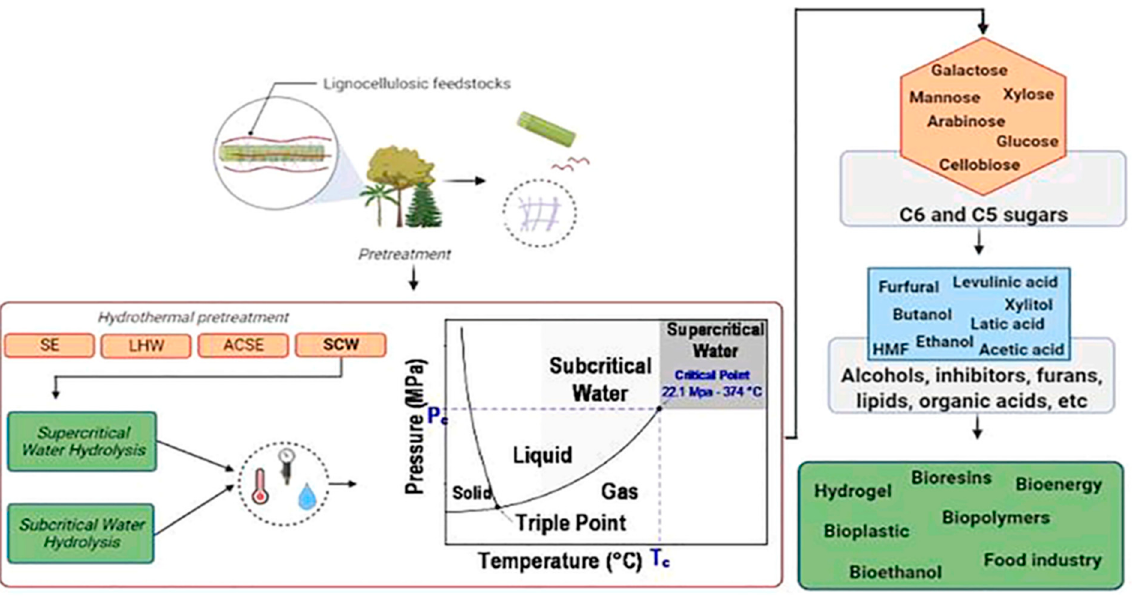
Figure 10. Hydrothermal pretreatments applied to lignocellulosic biomass and the possibility of multi-product recovery [72].